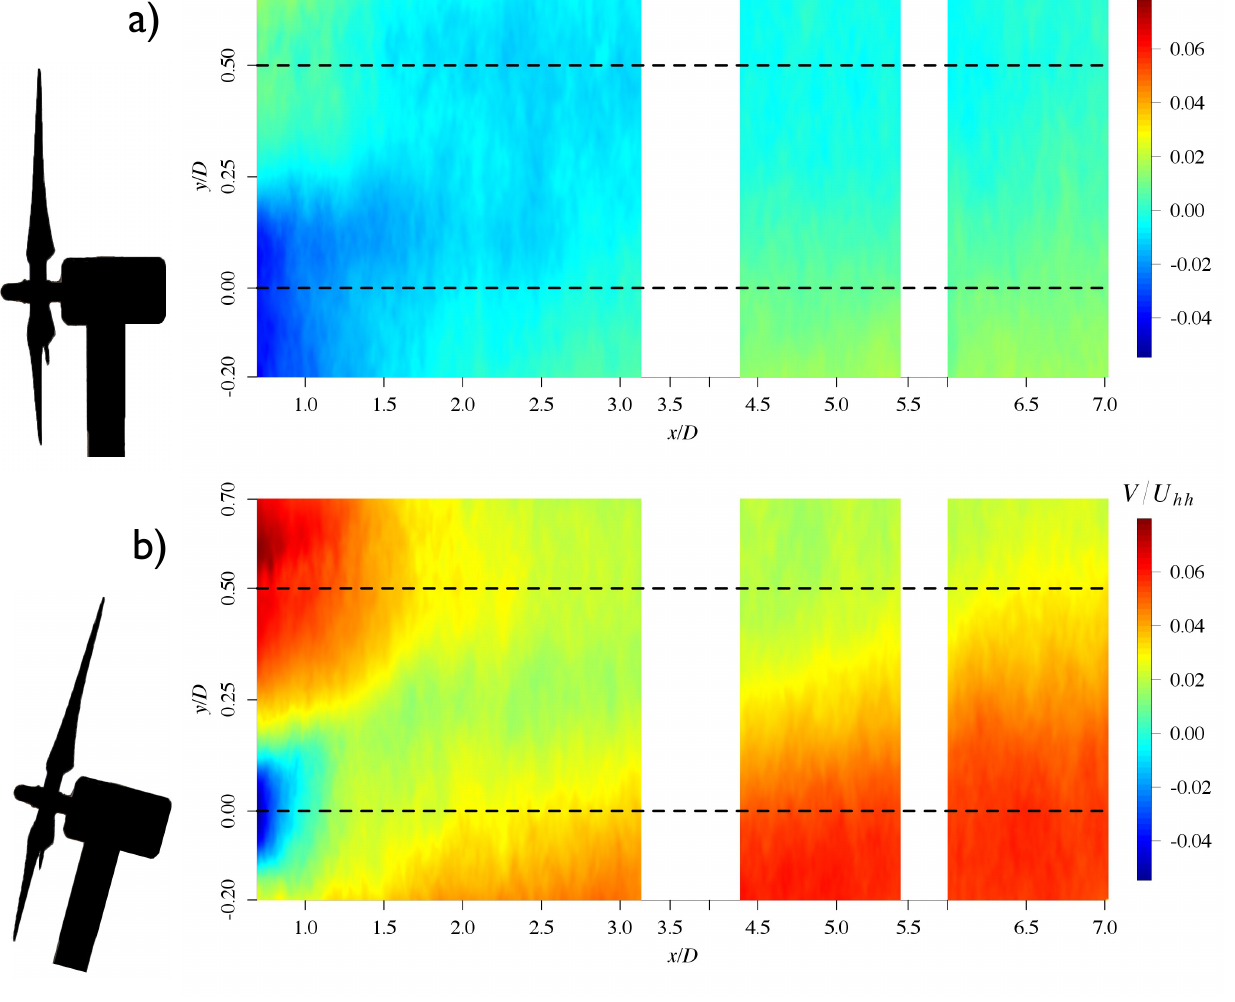
In contrast, the area of reversed flow in the corresponding location is more diffused in the fixed case. A faster recovery is observed in the floating case than the fixed